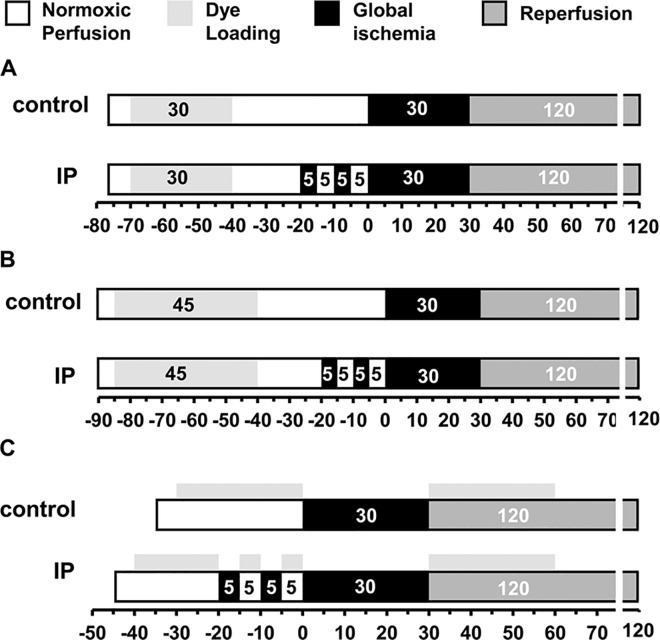
Perfusion protocols used for fluorescence measurements.A, A 30 min dye loading protocol was used for loading the heart with 5 μmol/L 5-cH2DCFDA, diAM, 0.4 μmol/L calcein-AM or 3 μmol/L MitoPY1. B, A 45 min dye loading protocol with recirculation was used to load the heart with 3 μmol/L Indo-1. C, Hearts were perfused with 5 μmol/L PO1 for 30 min before index ischemia and 30 min on reperfusion. Further details are given in Supporting Information.